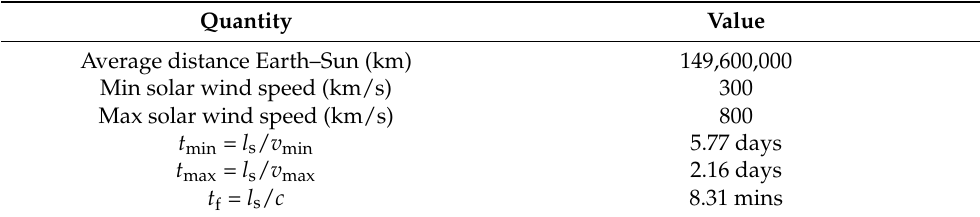
Table 2. The times, speeds, and distances relating to solar wind generation and